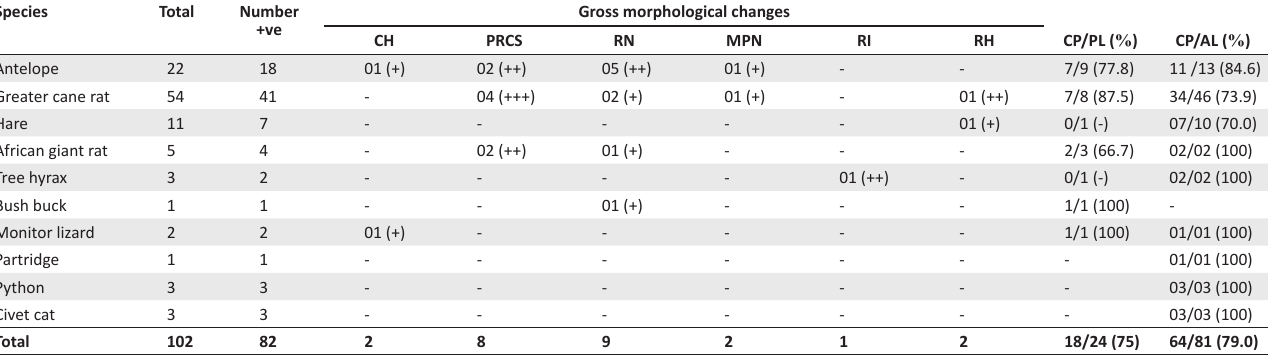
TABLE 4: Gross morphologic lesions of the kidney in relation to cultural isolation of Leptospira organisms. Species Total